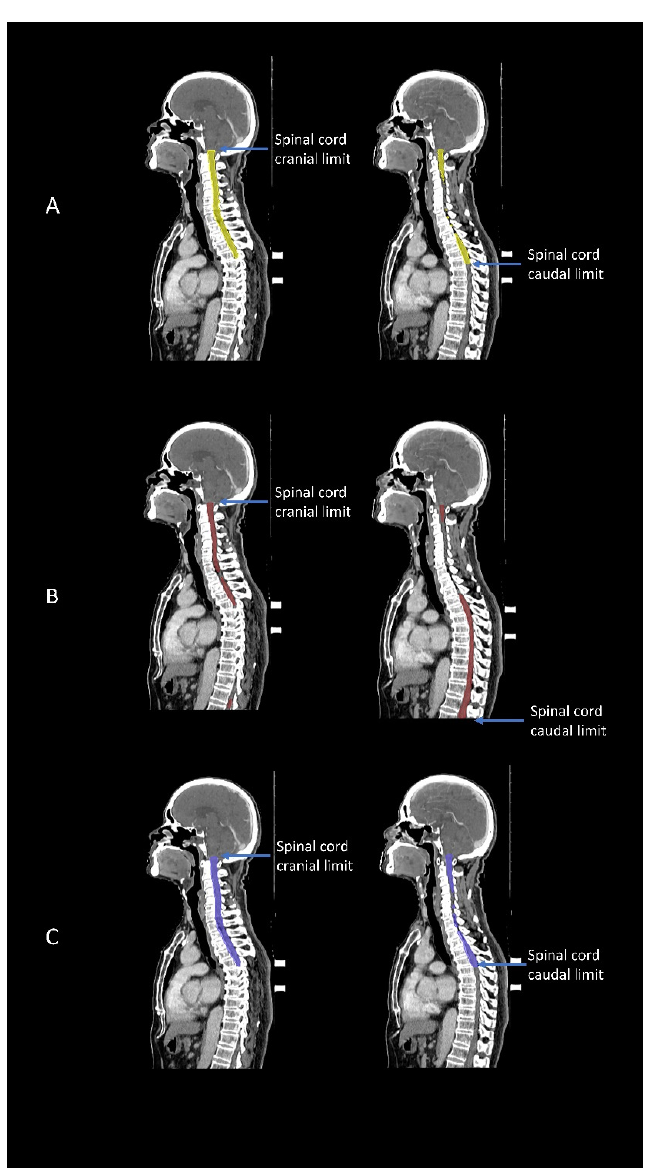
Figure 4. Sagittal view of spinal cord contouring for a 75-year-old man with T2N2M0 nasopharyngeal cancer by manual contouring ( A ), DL ( B ) (Dice similarity coefficient (DSC): 0.48, Hausdorff distance (HD): 188.62 mm, and 95th-percentile of Hausdorff distance (HD95): 91.27 mm) and atlas-based auto‐contouring ( C ) (DSC: 0.86, HD: 6.55 mm, and HD95: 2.34 mm).